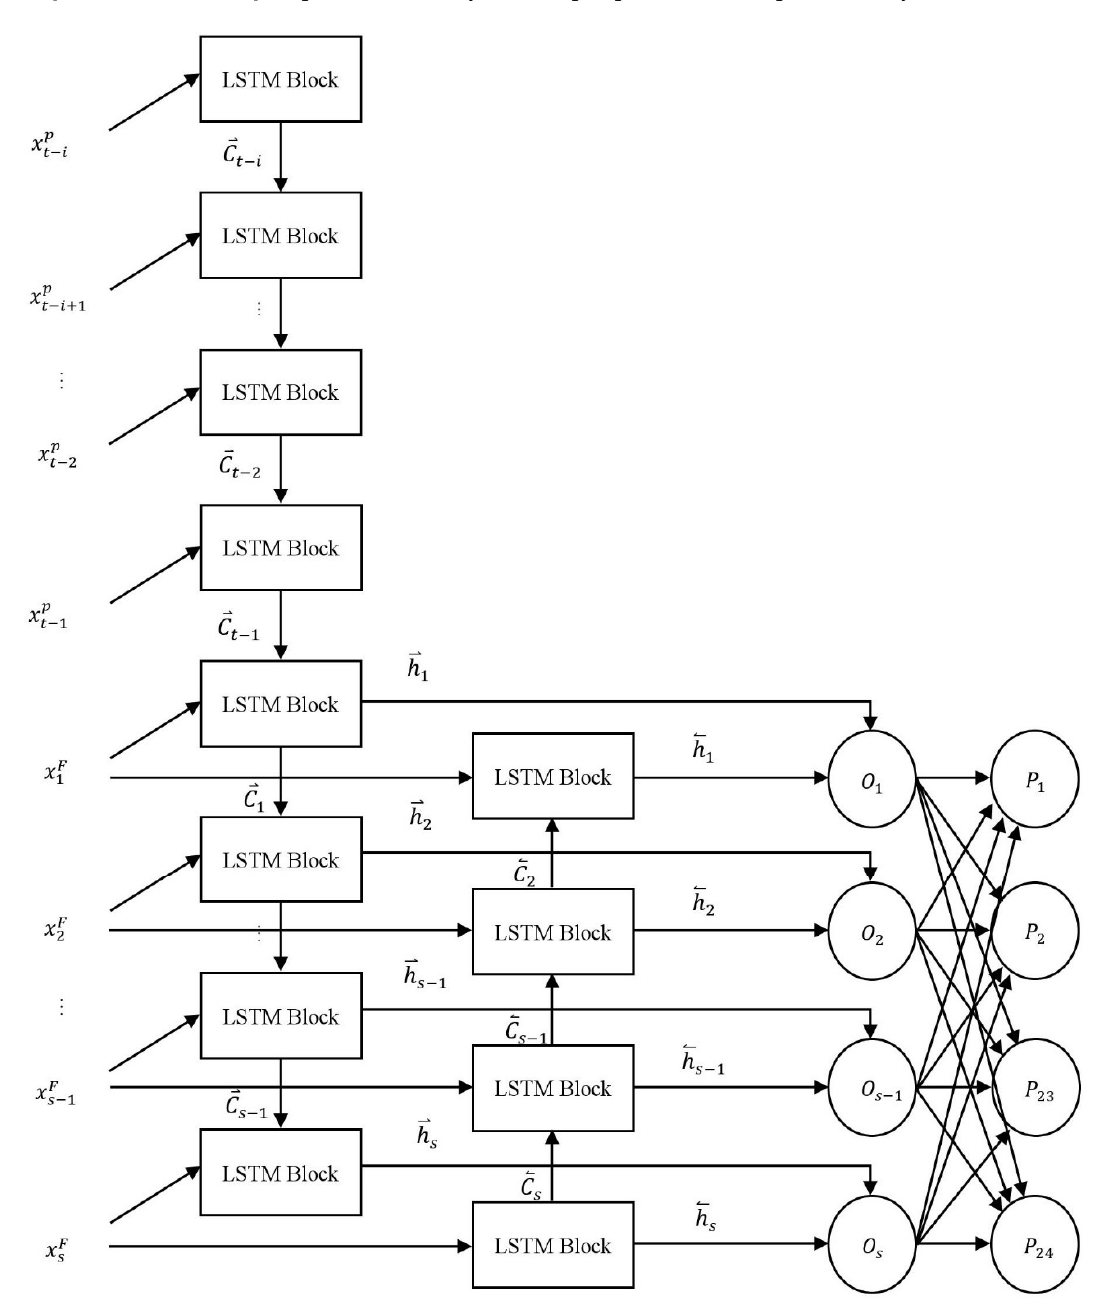
Figure 3. Bidirectional long short-term memory (LSTM) model for forecasting day-ahead prices.